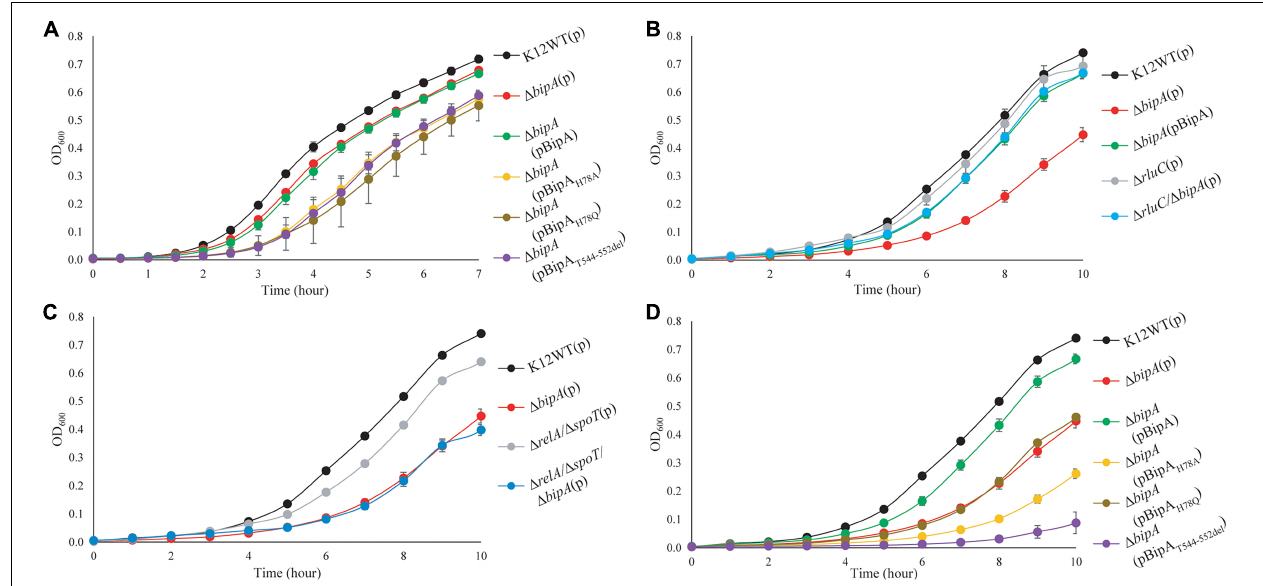
FIGURE 1 | Growth curves of E. coli wild-type, bipA -deficient, and complementation strains under optimal (37 ◦ C) and suboptimal (25 ◦ C) growth temperatures. (A) Growth curves at 37 ◦ C of E. coli with various BipA mutations. Under optimal condition, the strain (cid:49) bipA did not present a significant growth defect, but the strains (cid:49) bipA transformed with pCA24N-BipA variants presented a significant delay in growth. (B) Growth curves at 25 ◦ C of E. coli with deletions for bipA and/or rluC . Loss of bipA ( (cid:49) bipA ) led to growth defect at 25 ◦ C, which can be complemented by the presence of BipA expression (pCA24N-BipA) or suppressed by genomic deletion of rluC . The complementation was judged by the growth curve progression of the diverse strains ( (cid:49) bipA , (cid:49) bipA + pCA24N-BipA, (cid:49) rluC , and (cid:49) bipA + (cid:49) rluC ) in comparison to the wild-type strain (K12WT). (C) Growth curves at 25 ◦ C of E. coli with deletions for bipA , relA, and/or spoT. Deletion of both relA and spoT caused a slight growth delay but did not exacerbate the growth delay of (cid:49) bipA in the triple knock-out strains. (D) Growth curves at 25 ◦ C of E. coli with various BipA mutations. The (cid:49) bipA strain expressing pCA24N-BipA variants presented different growth curves at 25 ◦ C. The cells with BipA H78 Q demonstrated the same growth rate as the strain (cid:49) bipA (pCA24N), while preceding with BipA H78 A that preceded with BipA T544_ D 552 d el . Note that biological triplicates were analyzed, and pCA24N without gene of interest was transformed into cells not harboring any plasmid so that all strains have the similar cellular burden of holding a plasmid. The “p” in the bracket alone or preceding “BipA” represents plasmid